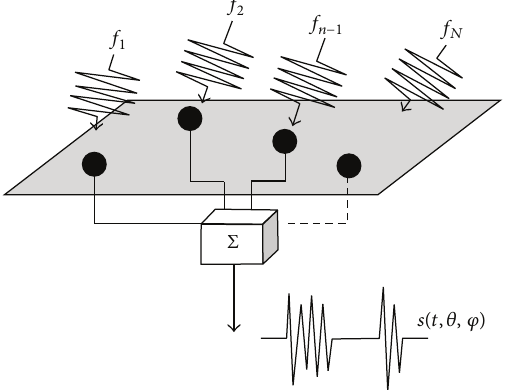
Figure 1: Two-dimensional time-domain antenna